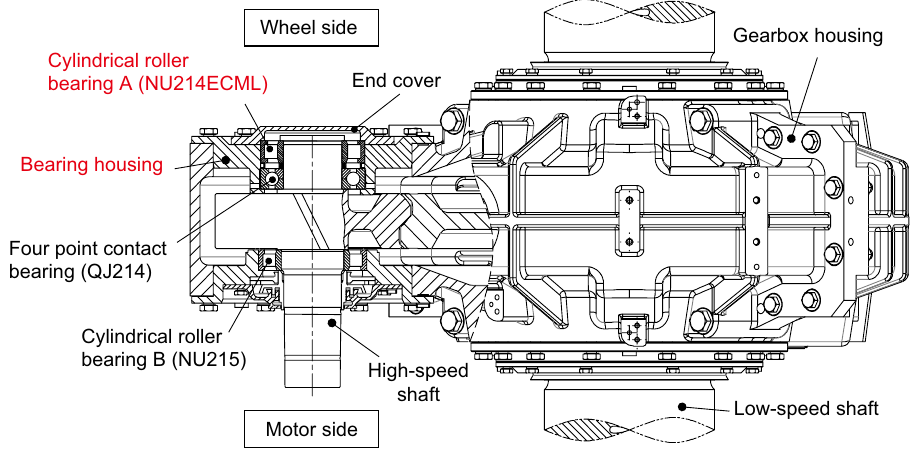
Fig. 1 Test gearbox structure and high-speed shaft bearing